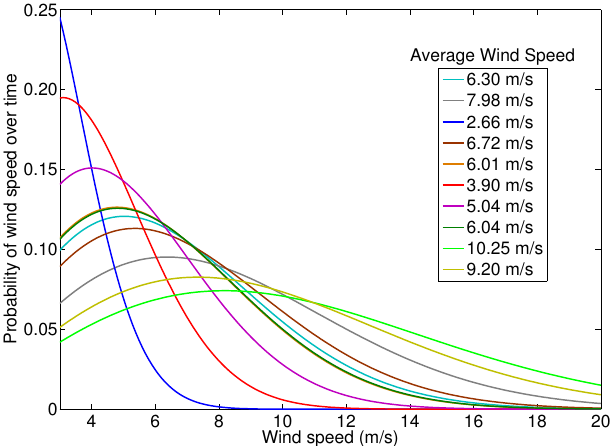
Figure 4. Rayleigh distributions capturing the wind speed variations over time for given average wind speeds